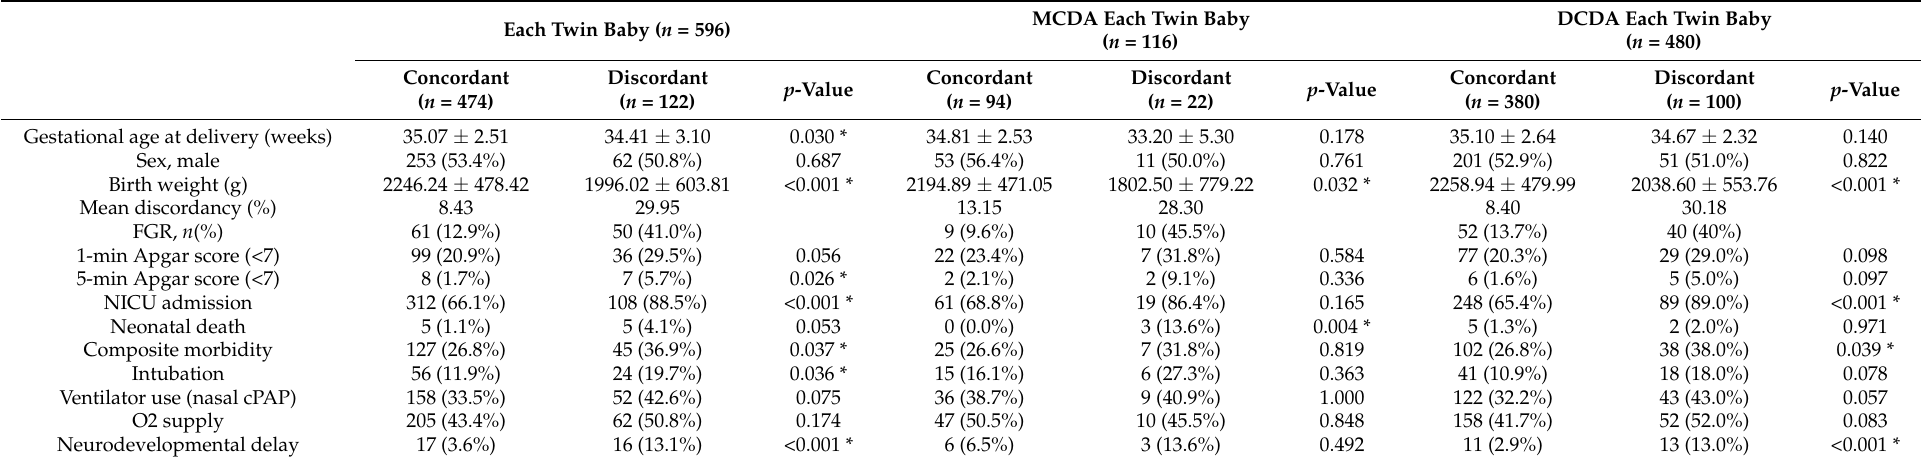
Table 2. Neonatal outcomes of concordant and discordant twins according to